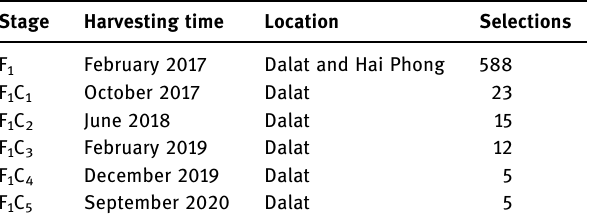
Table 1: Five most advanced clones shortlisted from the Lot 1 and Lot 2